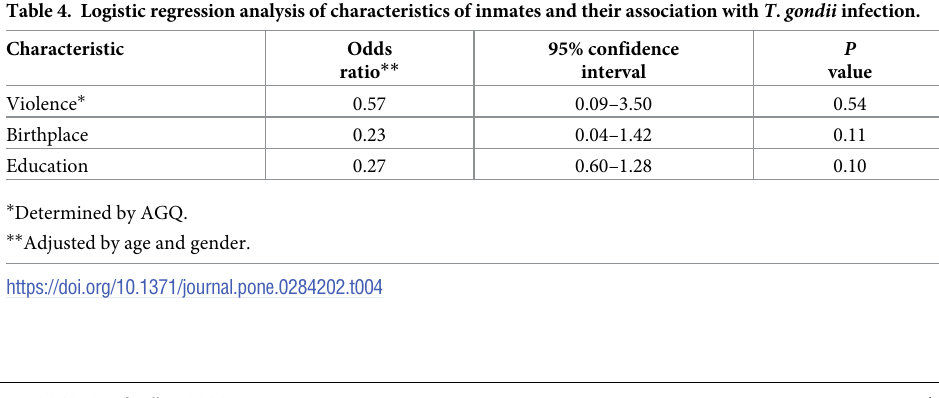
Table 3 shows the results of the AGQ scores found in inmates and the seroprevalence of T . gondii infection. Mean scores of the AGQ in T . gondii seropositive inmates (73.67 ± 29.09; 95% CI: 50.00–99.31) were similar to those (79.84 ± 25.00; 95% CI: 75.46–84.27) found in T . gondii seronegative inmates ( P = 0.55). Stratification by the type of aggression showed that the mean scores of anger, psychical aggression, verbal aggression, and hostility in T . gondii seropositive inmates were similar to those found in T . gondii seronegative inmates.